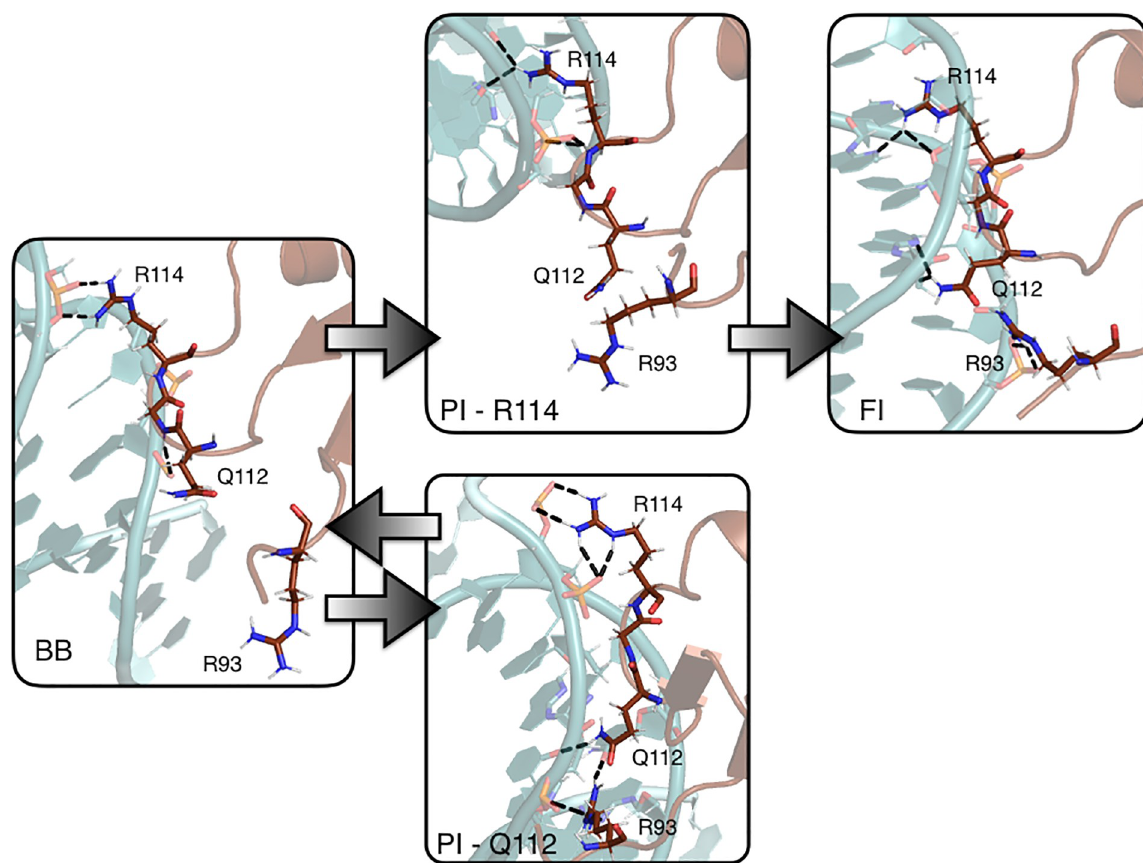
Fig 8. Mechanism of H-NS binding to AT-rich DNA. Snapshots of the modes of interaction between H-NS and DNA. The protein (brown) and DNA (light blue) are shown in cartoon representation. The QGR motif and R93 are shown as sticks. The arrows indicate in which direction the transitions occurred in the RETIS